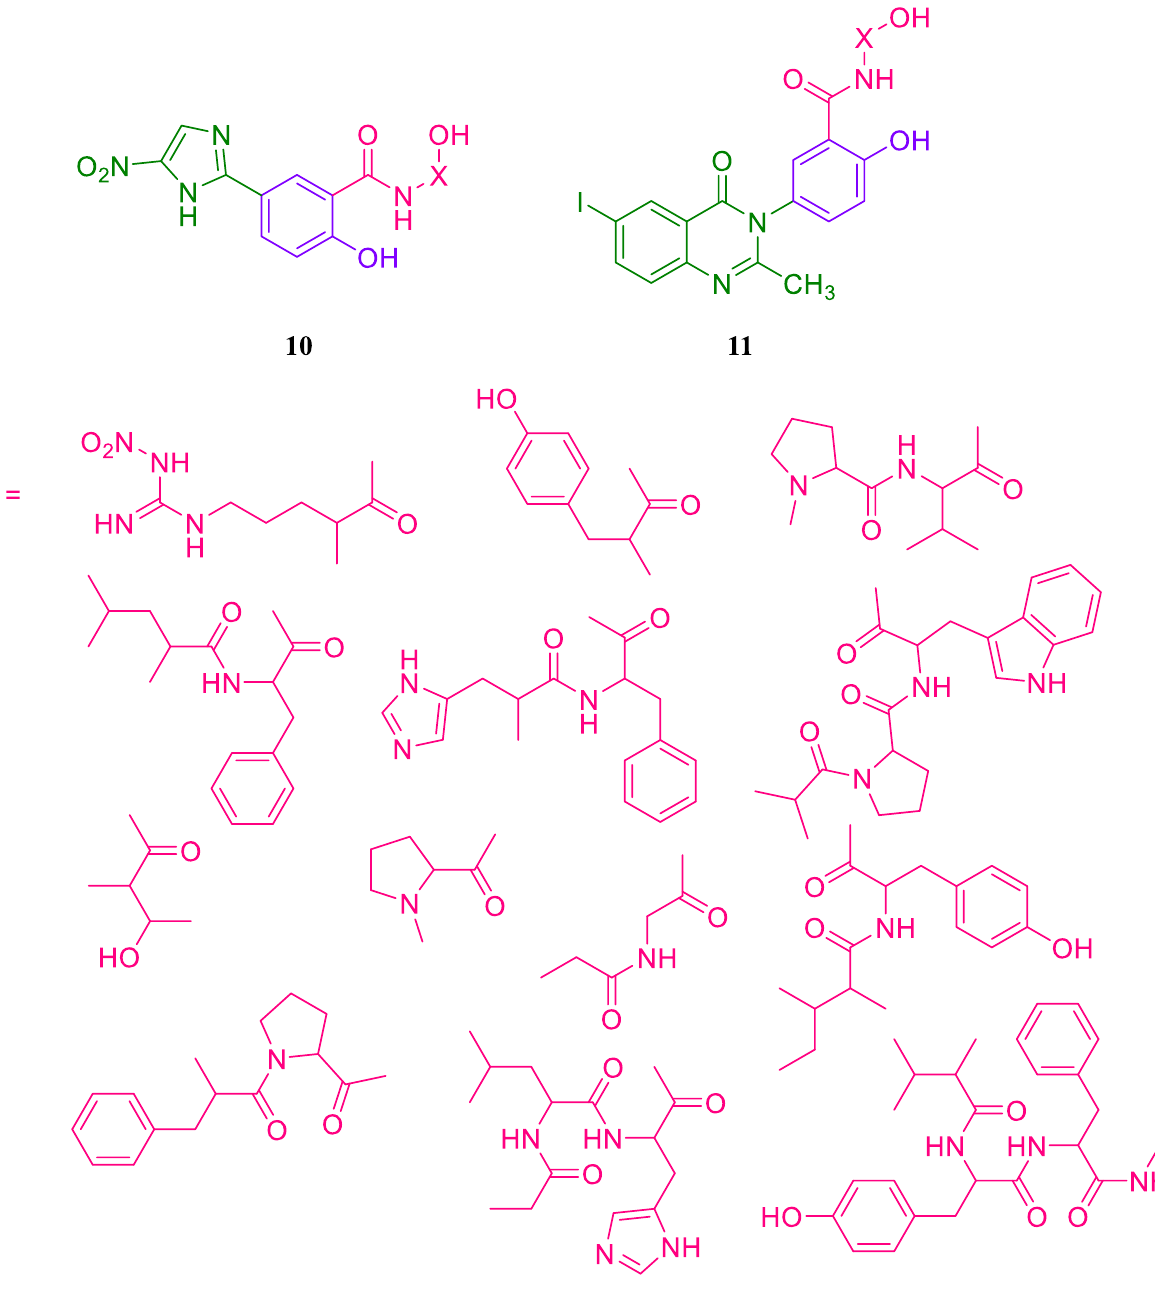
Figure 19. Imidazolo-/quinazolino-peptide derivatives.